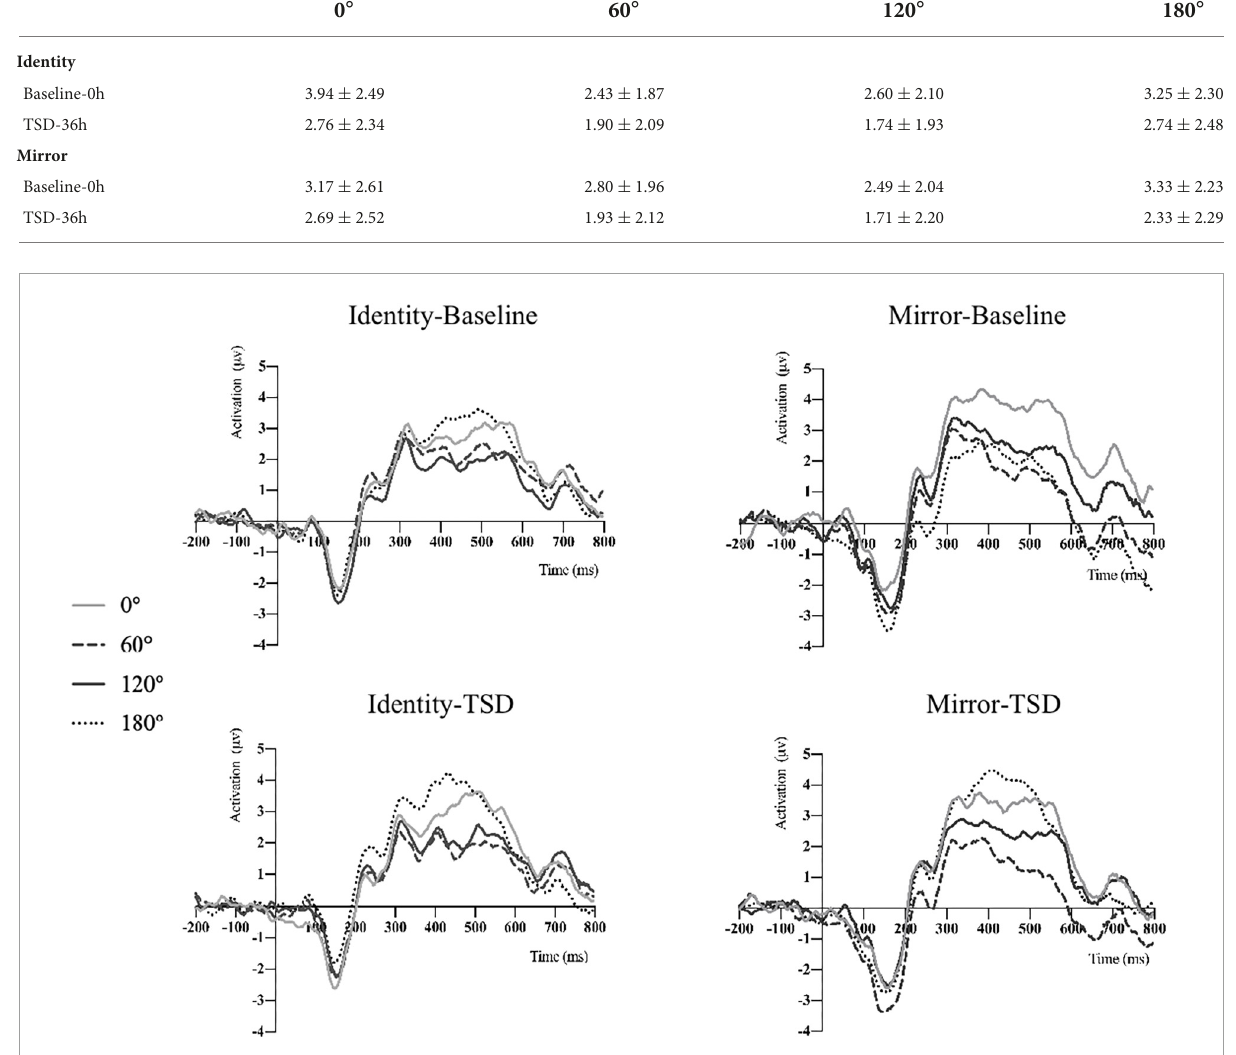
TABLE 5 Mean and standard deviation (SD) for the average amplitude of P300 at baseline and TSD, separate for identical and mirror conditions.